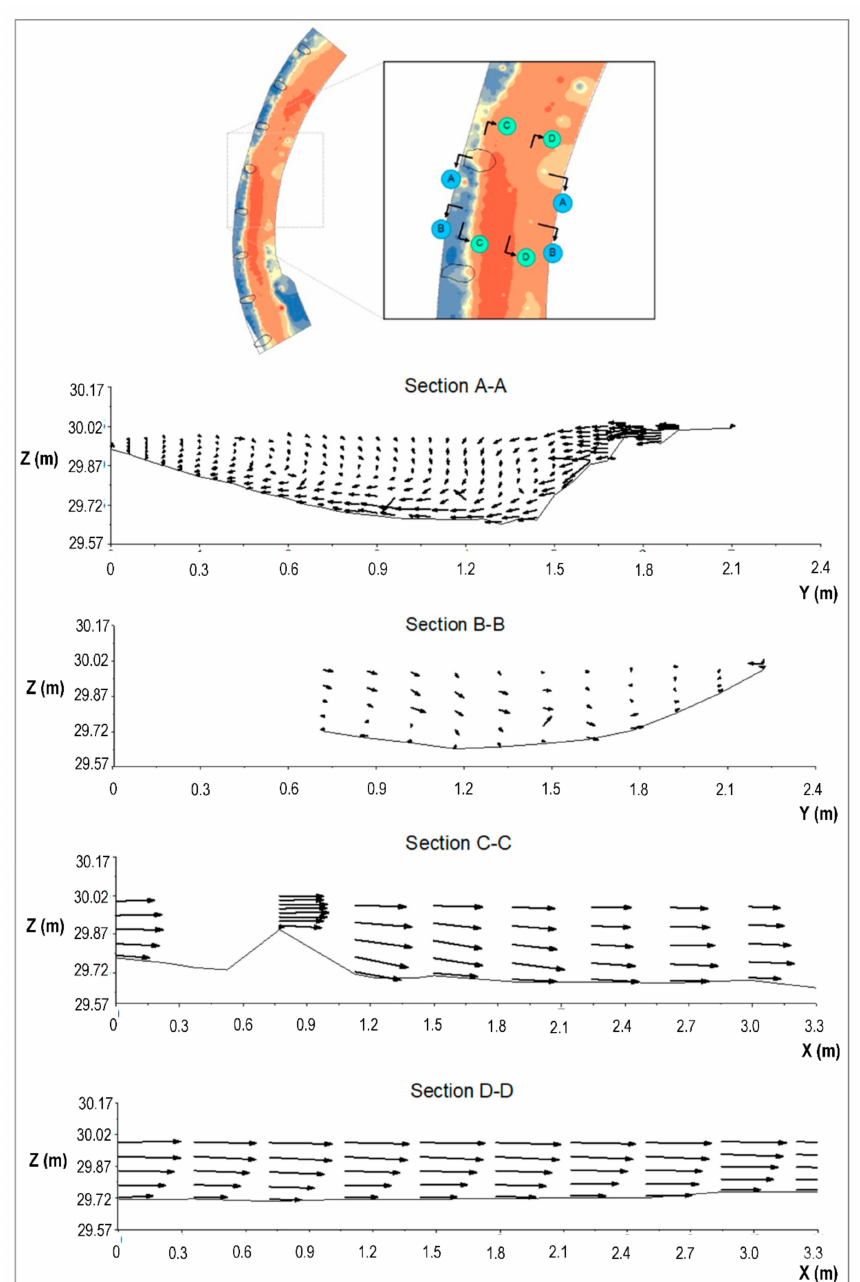
Figure 21. Measured velocity vectors for rock vane configuration